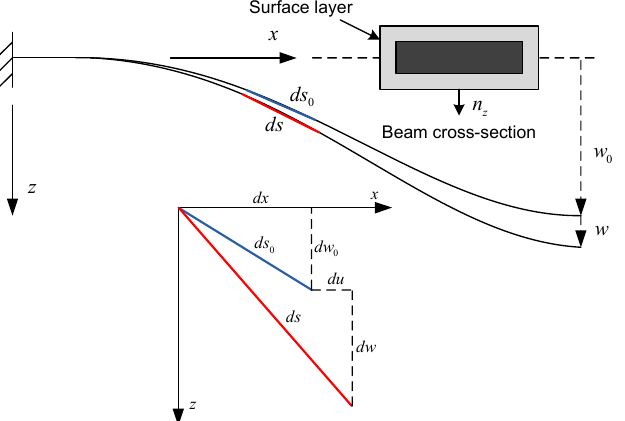
Figure 3. A segment of the nanobeam showing deflection w beyond initial curvature height w 0 . An element along beam span is shown elongating from ds 0 to ds due to beam